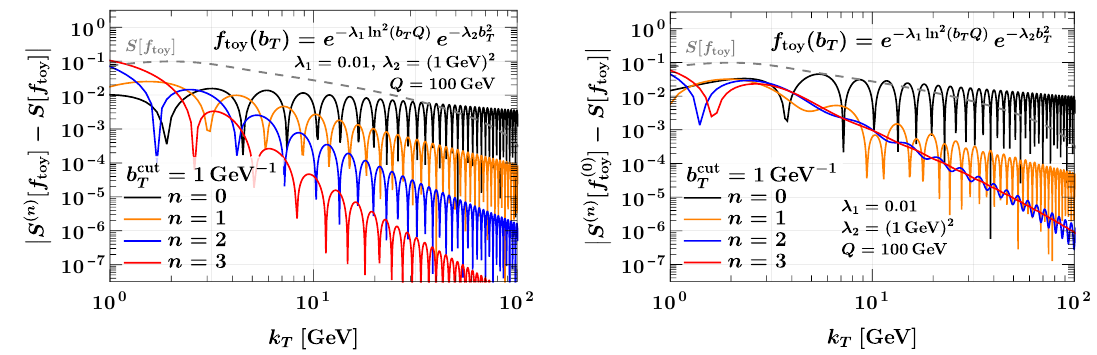
Figure 2 . Left: scaling of error terms of the truncated functionals for the k T spectrum of the toy test function in eq. (2.22). The error terms (computed as the difference to the exact result) exactly follow the expected scaling ∼ k n − 1 / 2 . Right: same, but instead applying the truncated functionals T to the leading “OPE” contribution f (0) for the test function. The difference to the full result toy